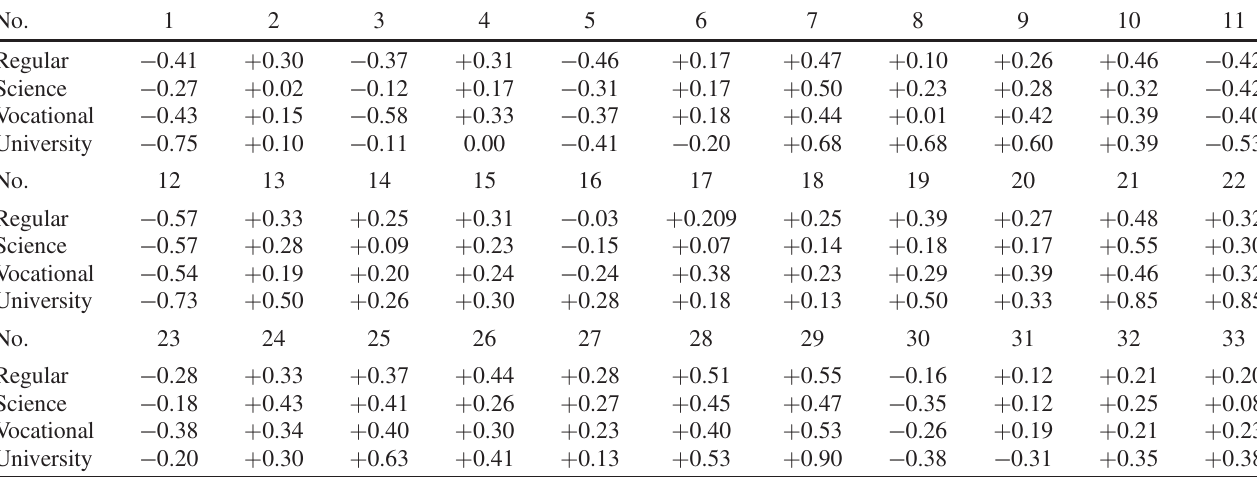
TABLE VIII. Normalized scores on each item for different school types.